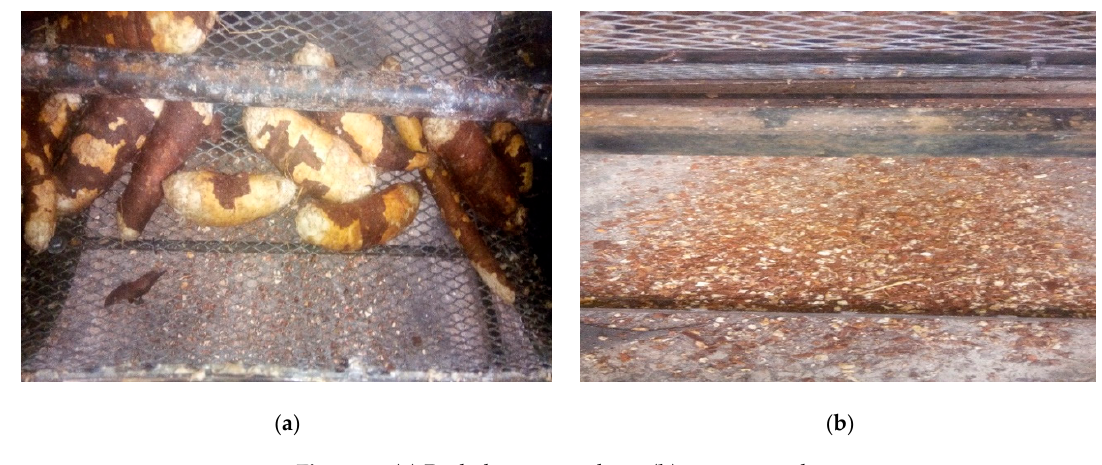
Figure 5. Tuber peeling machine ( a ) Side view; ( b ) Front view.